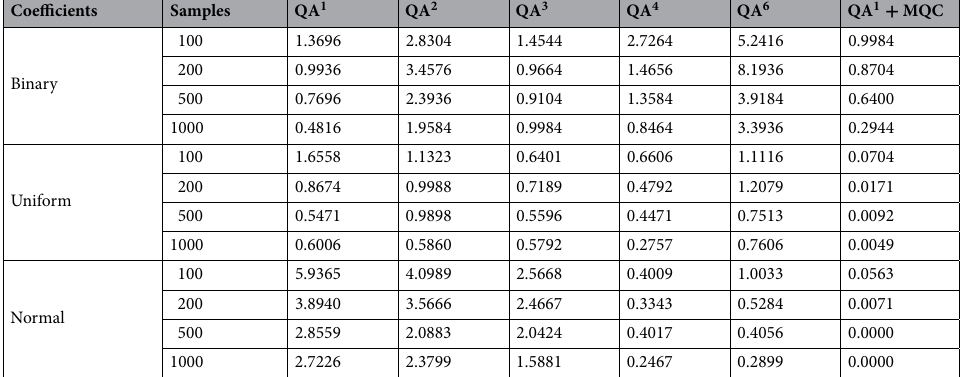
Table 1. Comparing the robustness (or reproducibility of results) of applying MQC to raw samples attained by a quantum annealer ( QA 1 + MQC ) with recent software/hardware advances—namely quantum annealing with five spin-reversal transforms ( QA 2 ) , quantum annealing with longer inter-sample delay ( QA 3 ) , quantum annealing with optimization postprocessing ( QA 4 ) , and quantum annealing with five spin-reversal transforms, longer preparation time and optimization postprocessing ( QA 6 ) . Each element represents the variance of energy values from repeating the corresponding method 50 times.